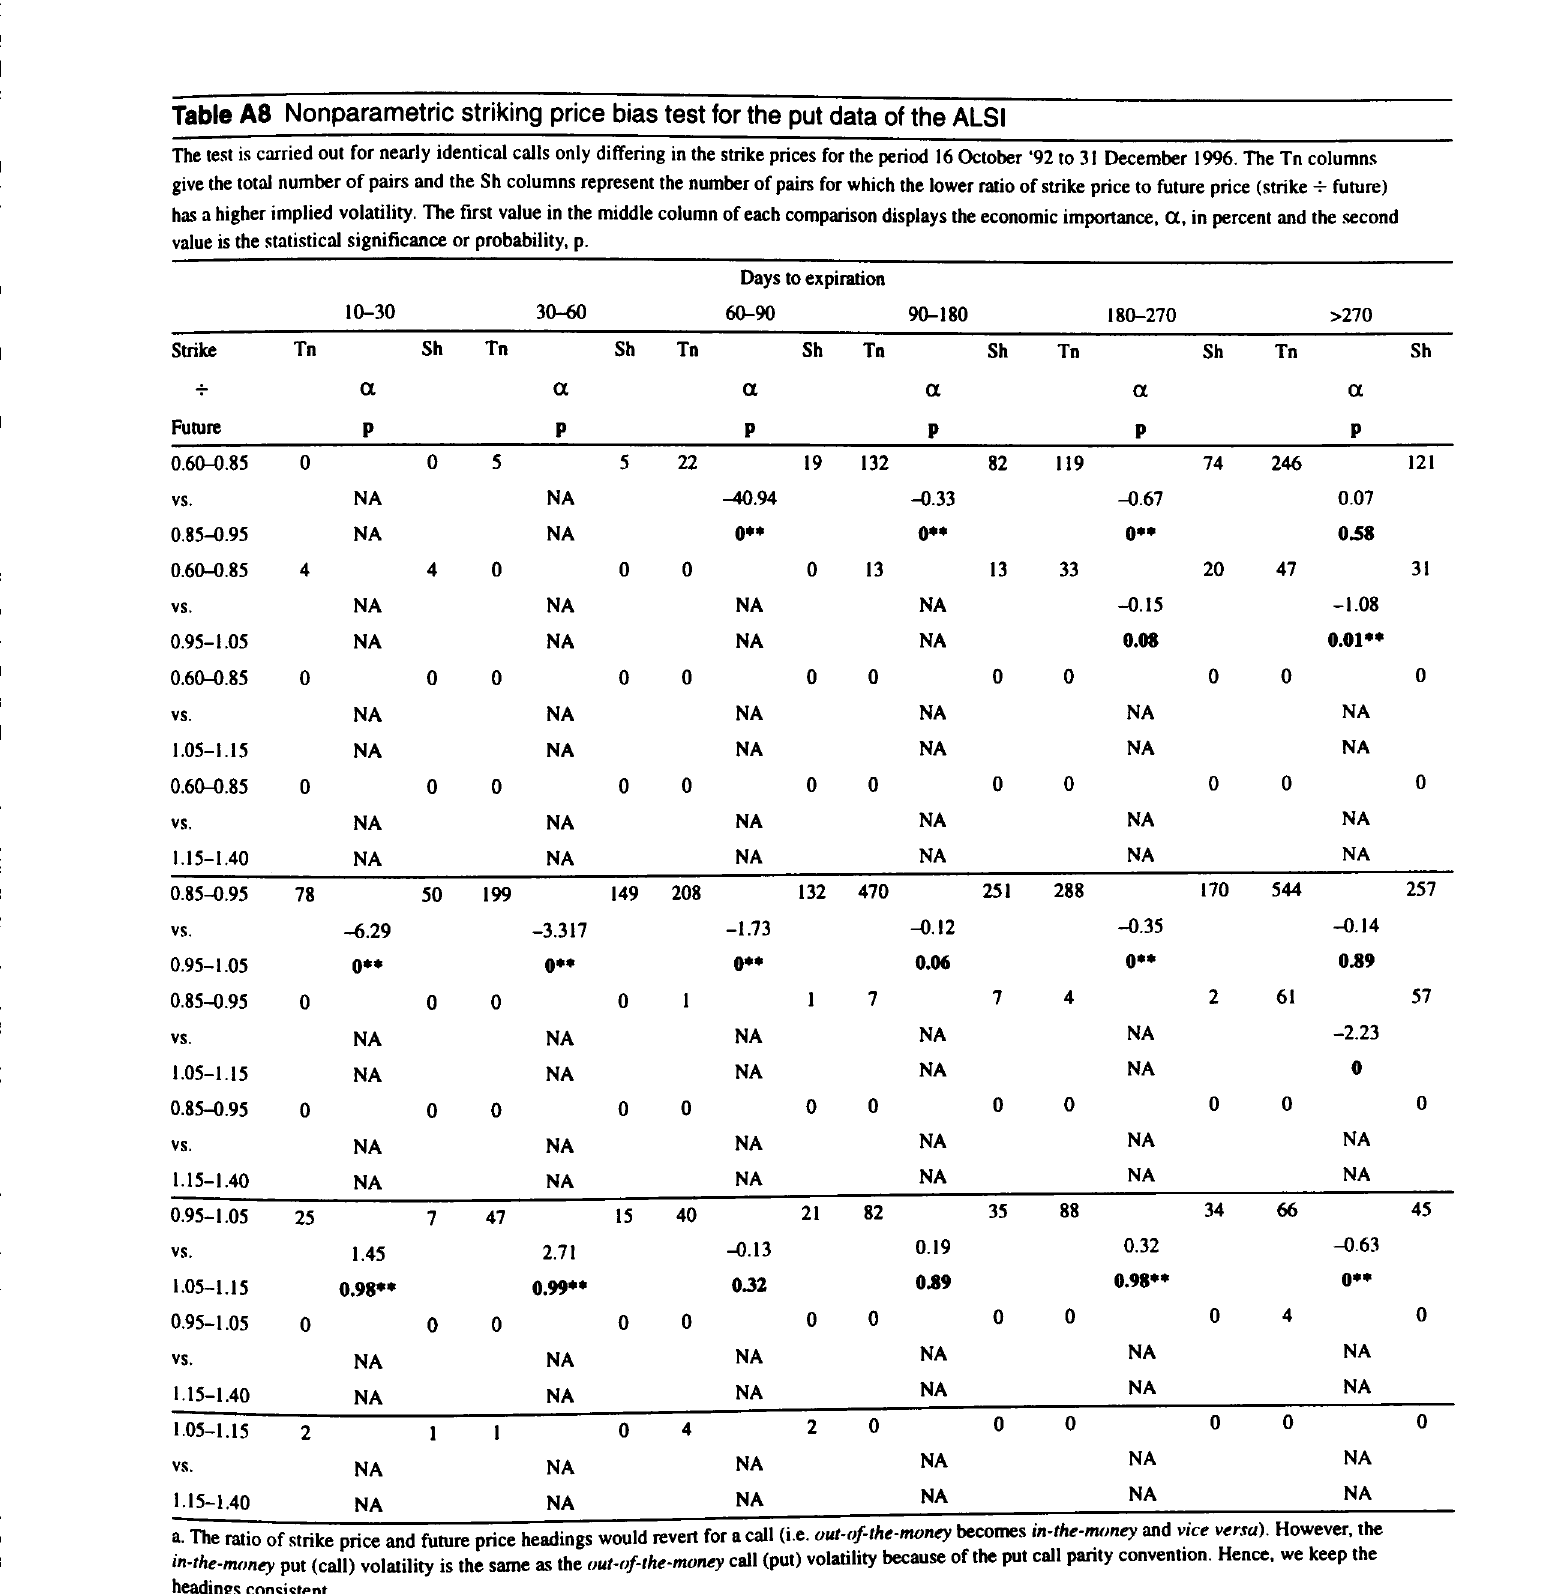
Table AS Nonparametric striking price bias test for the put data of the ALSI The test is carried out for nearly identical calls only differing in the strike prices for the period 16 October '92 to 31 December 1996. The Tn columns give the total number of pairs and the Sh columns represent the number of pairs for which the lower ratio of strike price to future price (strike+ future) has a higher implied volatility. The first value in the middle column of each comparison displays the economic importance, a, in percent and the second value is the statistical significance or probability,